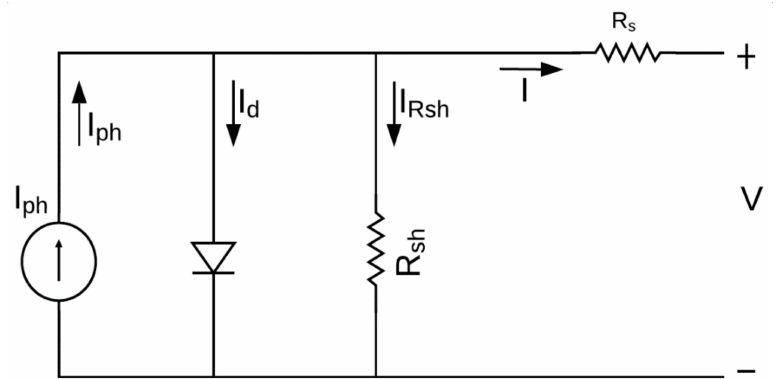
Figure 1. Photovoltaic (PV) cell equivalent